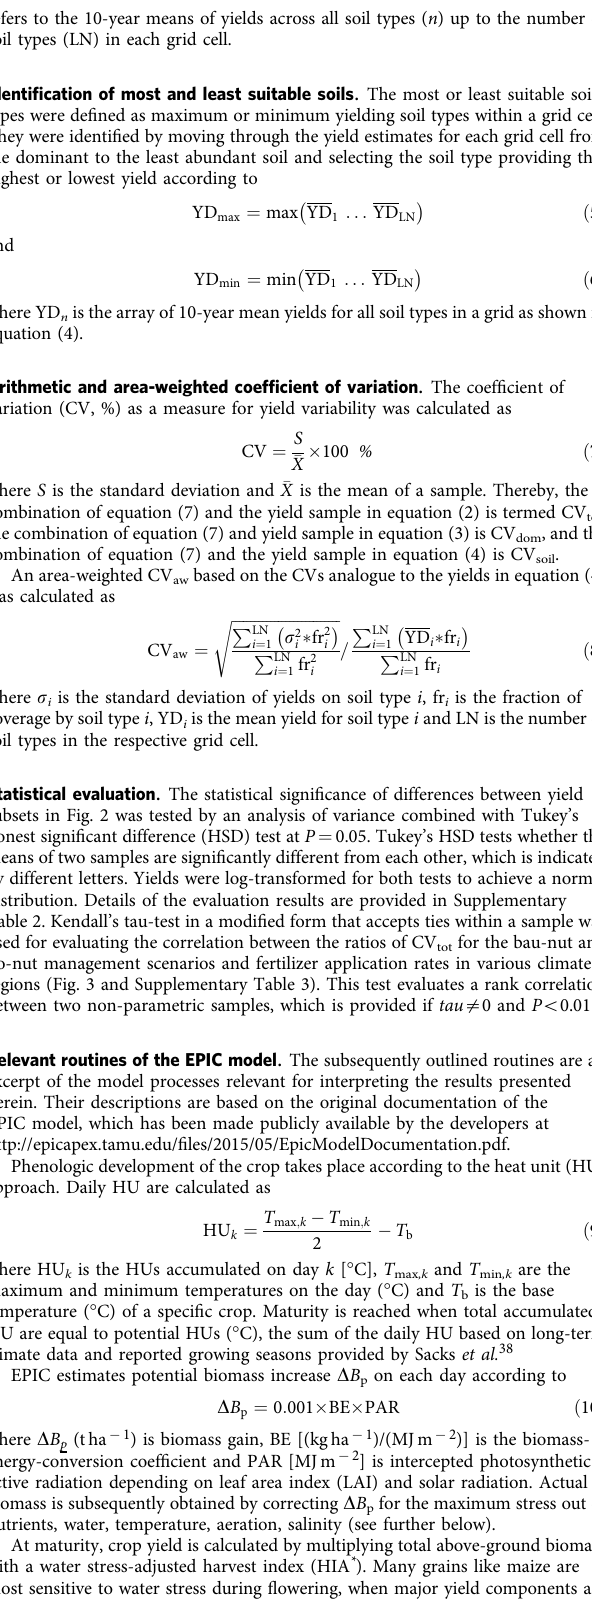
NATURE COMMUNICATIONS|7:11872|DOI: